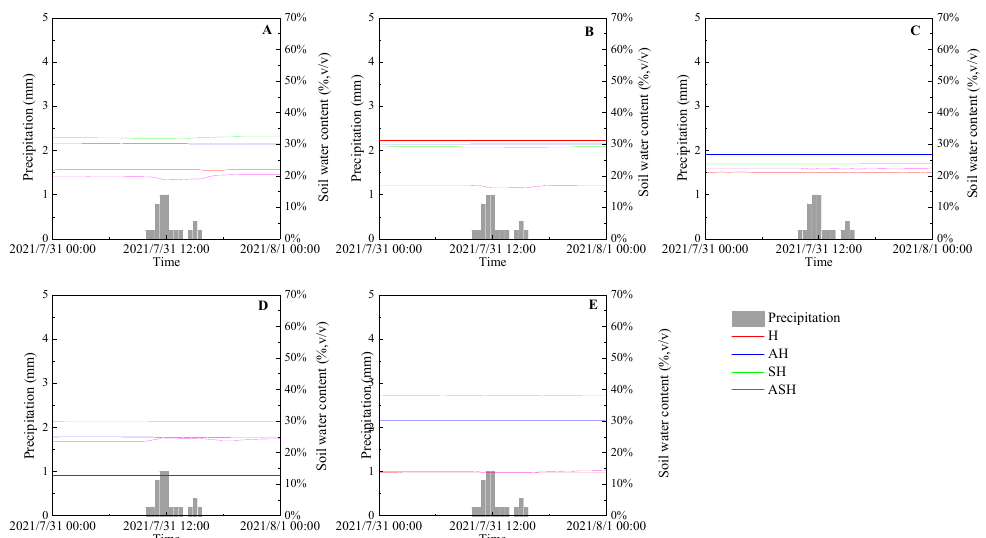
Figure 5. The variations of soil moisture content at light rain event. (A) 0 – 10 cm, (B) 10 – 20 cm, (C) 20 – 30 cm, (D) 30 – 50 cm, (E) 50 – 70 cm.